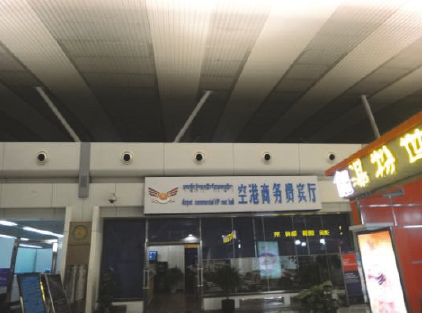
Figure 3: Ejector nozzle air supply outlets in the departure hall.